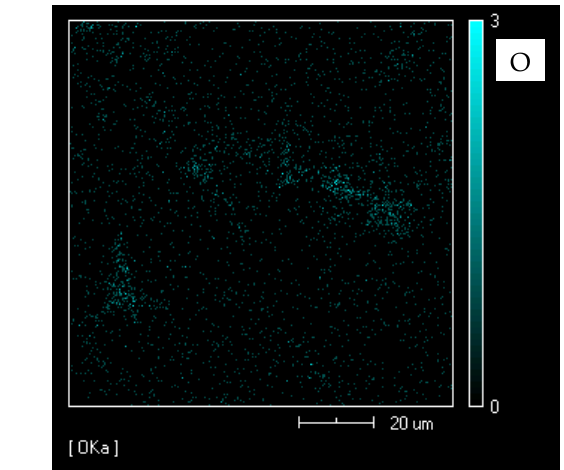
Figure 6. SEM images of AZ80 alloy and its distributions of elements in A-zone.